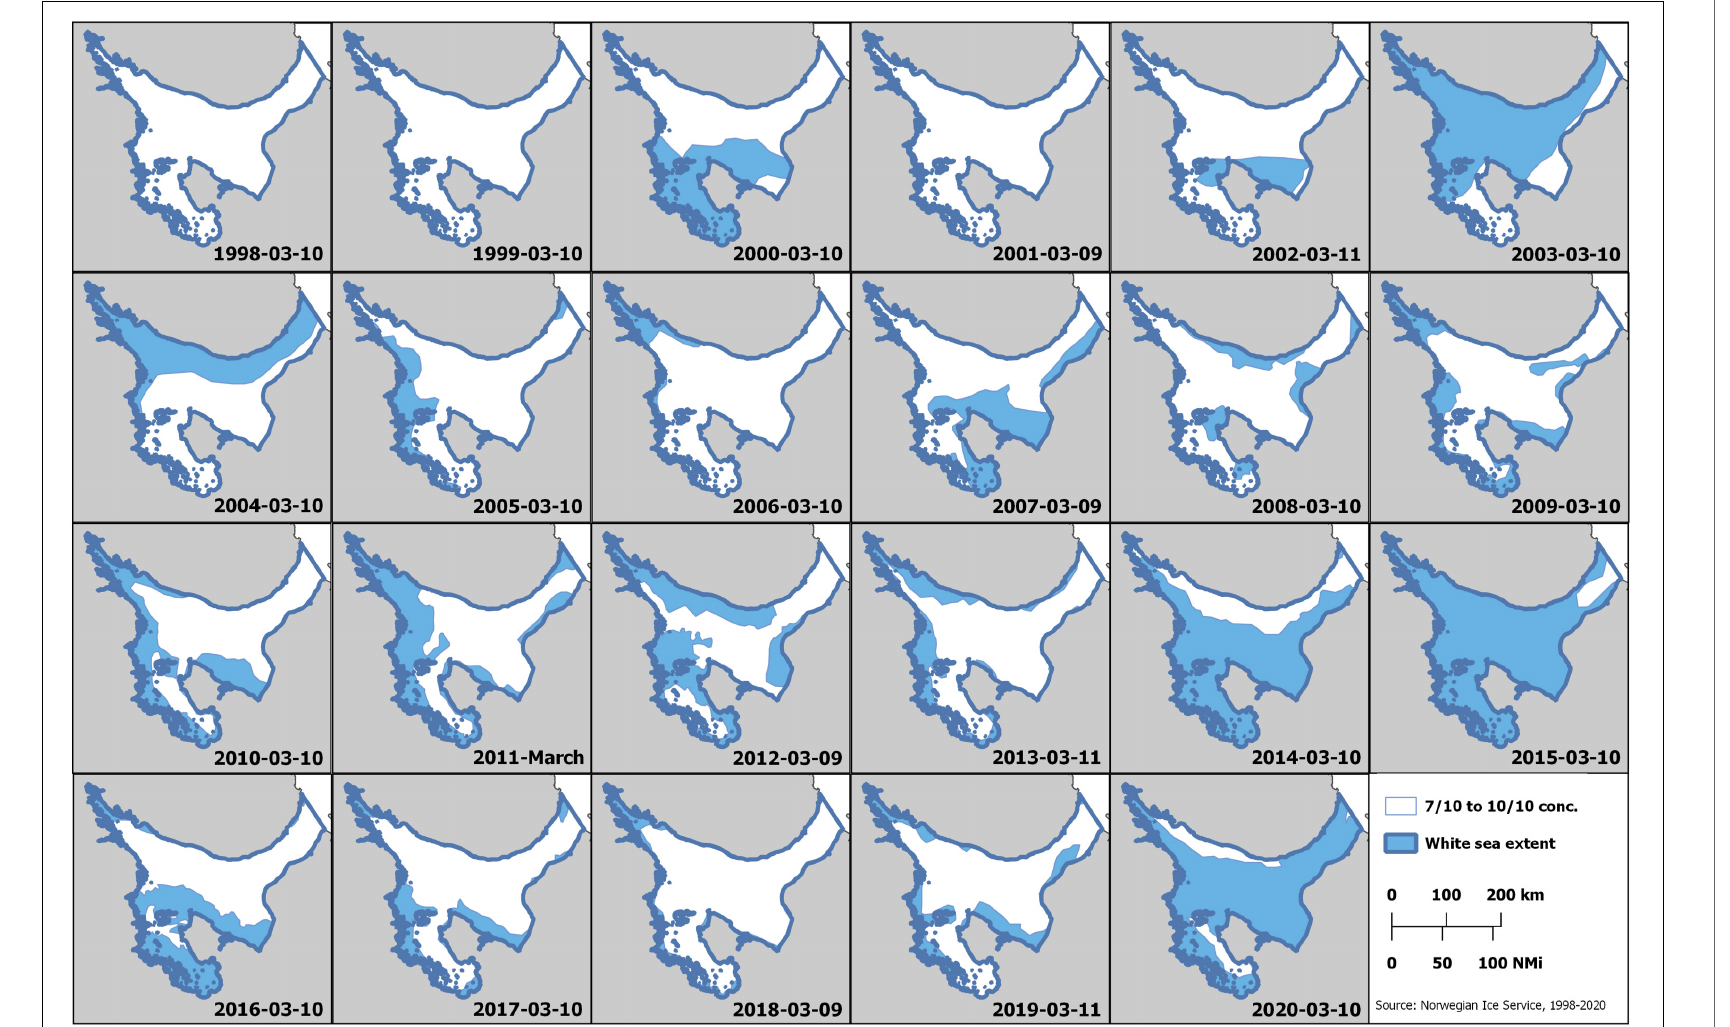
FIGURE 4 | Occurrence of drift ice (4+/10 coverage) in the White Sea on 10 March 1998-2020. Data from the Norwegian Meteorological Institute Cryo web portal